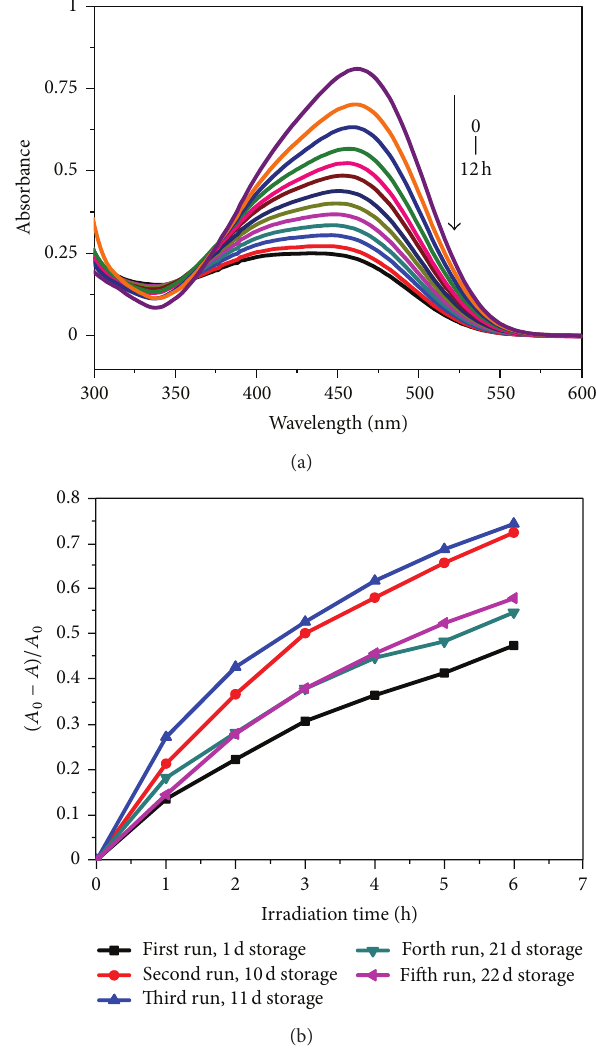
Figure 6: Decoloring MeOr in the PMR with the ZnO NPs immobi- lized on the membrane surface. (a) UV-Vis spectrum of MeOr at 1h intervals (1–12h) for the first cycle; (b) photocatalytic experiments for 5